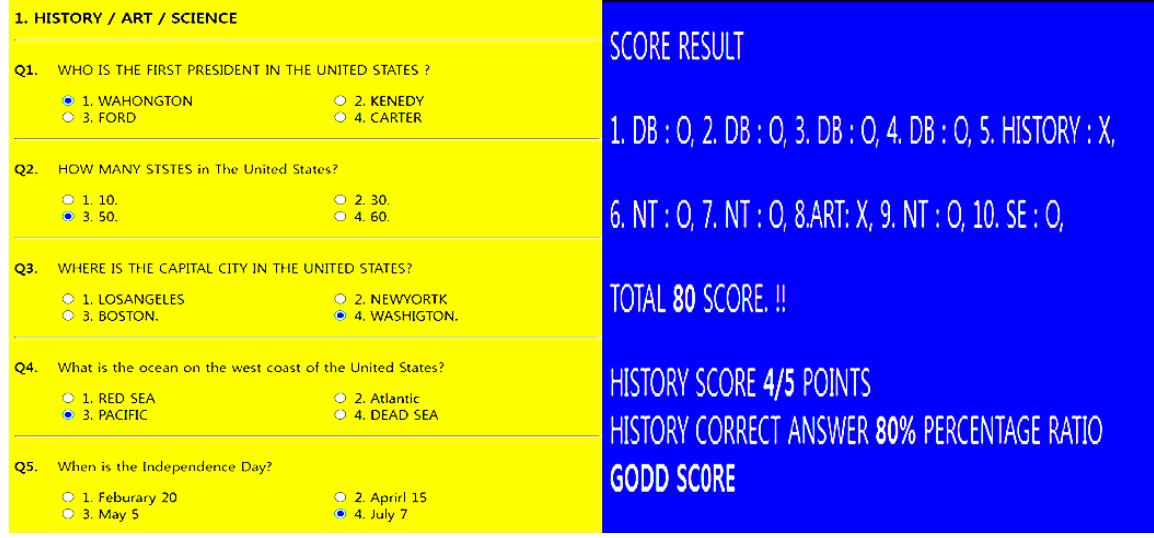
Figure 6. Test score evaluation screen.